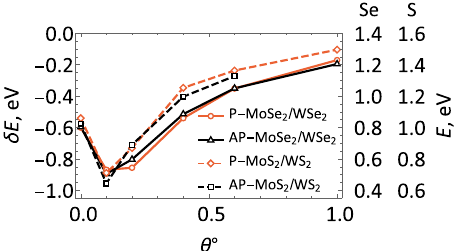
Fig. 5 Energies of SPEs in P/AP-WX2/MoX2 bilayers shown as a shift from the lower iX energy inside the domains (left-side axis common for all bilayers) and as an absolute value (right-side axis speci fi ed separately for selenides and sul fi des). The latter were determined as E = δ E + 1.4 eV and E = δ E + 1.6 eV for selenide (Se) and sul fi de (S), respectively. These estimates are based on calculated binding energies of iXs ≈ 65 meV (see details in Supplementary Section 2) and measured positions of photoluminescence peaks of iXs in MoSe 2 /WSe 230 and MoS 2 /WS 247 .